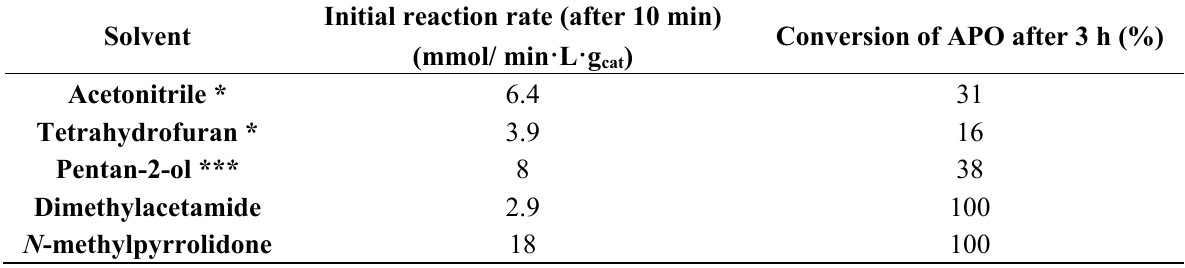
Table 4. Initial reaction rate in isomerization of α -pinene oxide using various